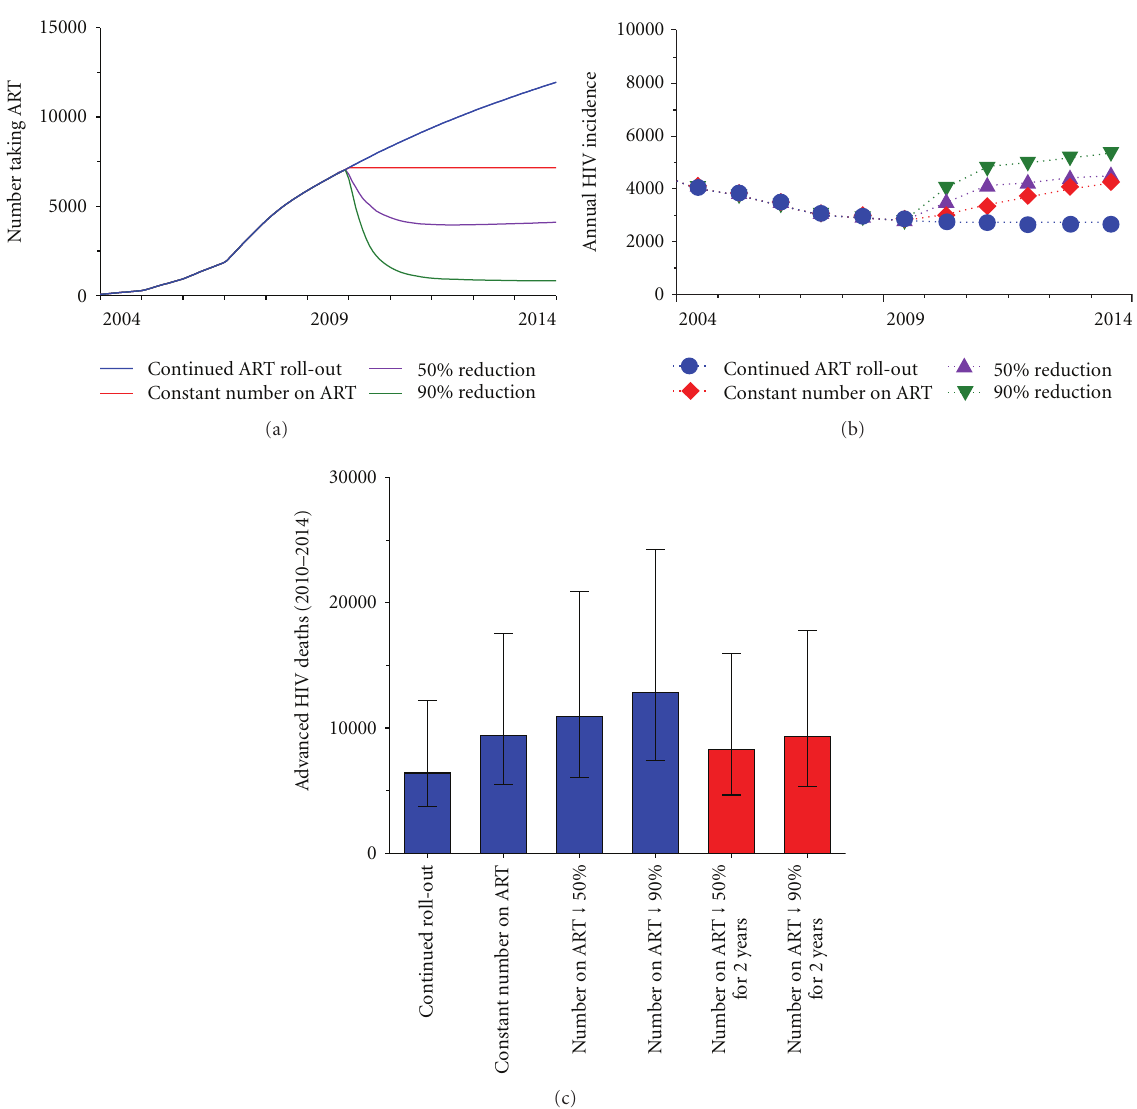
Figure 3: The impact of reductions in ART availability. (a) Median number of HIV-infected people receiving ART for scenarios from (i) to (iv) in the text. These scenarios were a continuation of the ART roll-out after 2009, maintaining ART services so that the number of people who receive ART remains constant, a reduction in the number of people receiving treatment of 50% from the level at the end of 2009, and a reduction in the number of people receiving treatment of 90% from the level at the end of 2009. (b) Median annual incidence per 100 person-years after 2009 for 100 simulations of each of the scenarios considered. (c) Total number of advanced HIV deaths for the period 2010–2014 for all the scenarios considered. The blue bars represent the median number of deaths for scenarios from (i) to (iv) in the text with the black error bars showing the minimum and maximum number of deaths for 100 model simulations of each scenario. Similarly, the red bars represent the median number of deaths for the scenarios where ART programs and services are interrupted for two